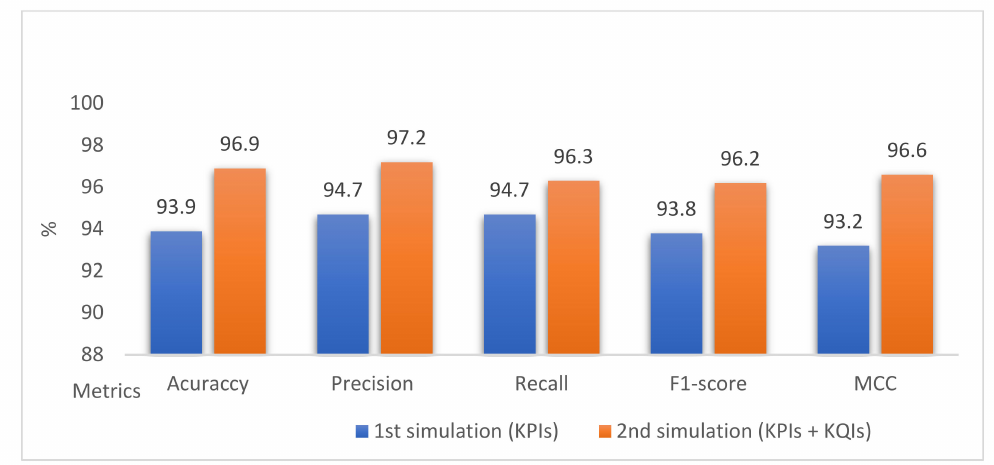
Figure 6. Comparison of the results obtained by the Random Forest model in both